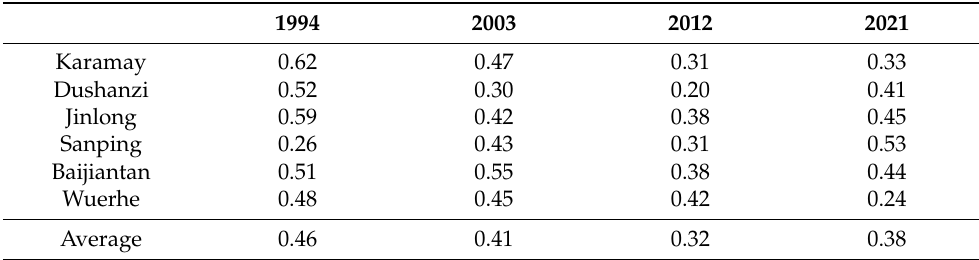
Table 4. Values of urban compactness of each township in 1994, 2003, 2012, and 2021.